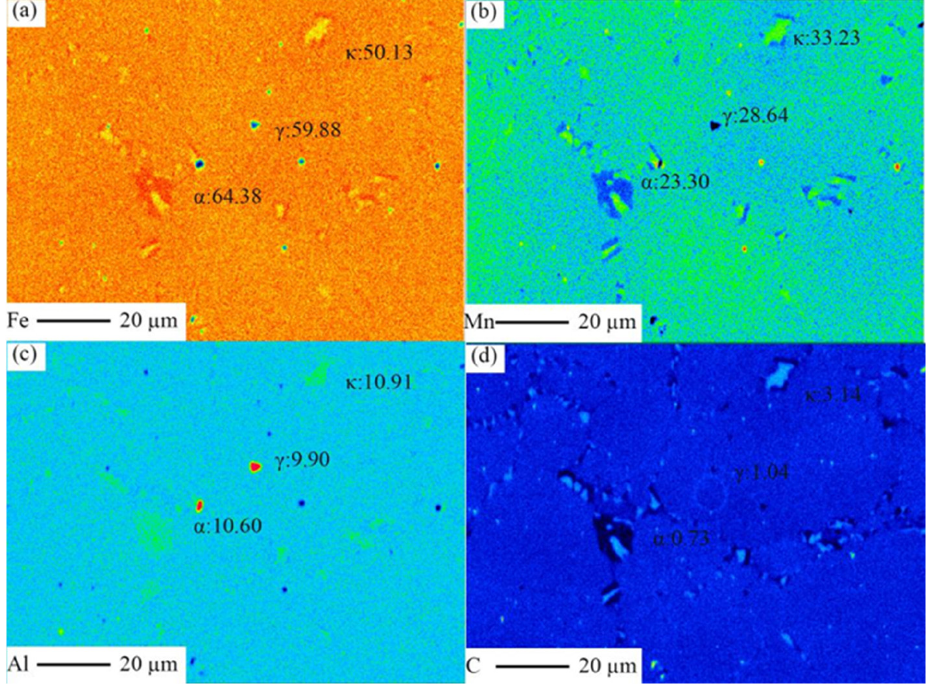
Figure 5. Fe ( a ), Mn ( b ), Al ( c ), and C ( d ) element distribution in a furnace-cooling sample with Al addition of 11% were characterized by EPMA.